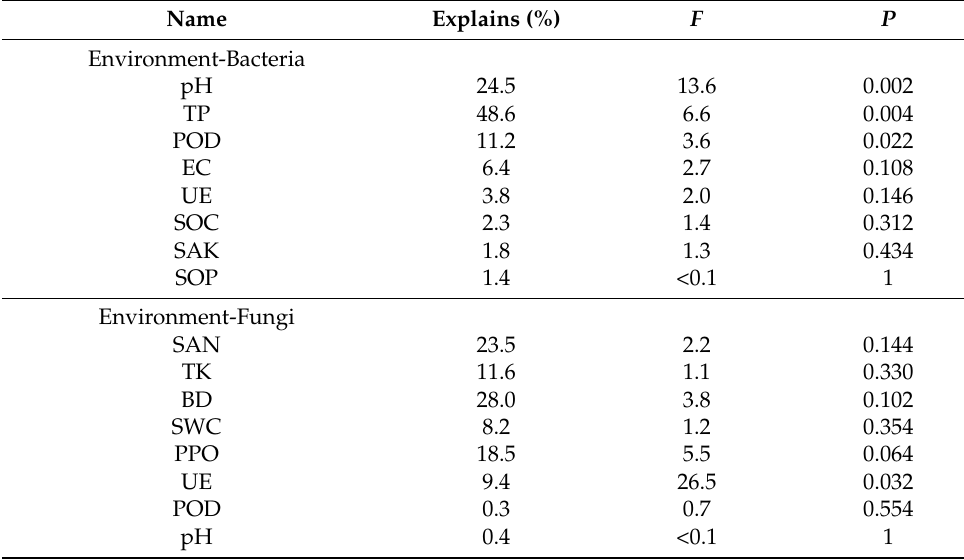
Table A5. Redundancy analysis of soil bacteria and fungi, soil environmental